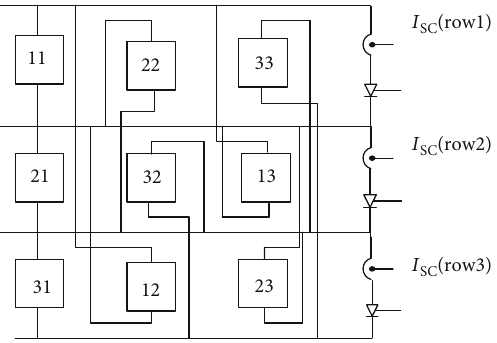
Figure 7: Block diagram for extracting short-circuit currents of rows in a 3 × 3